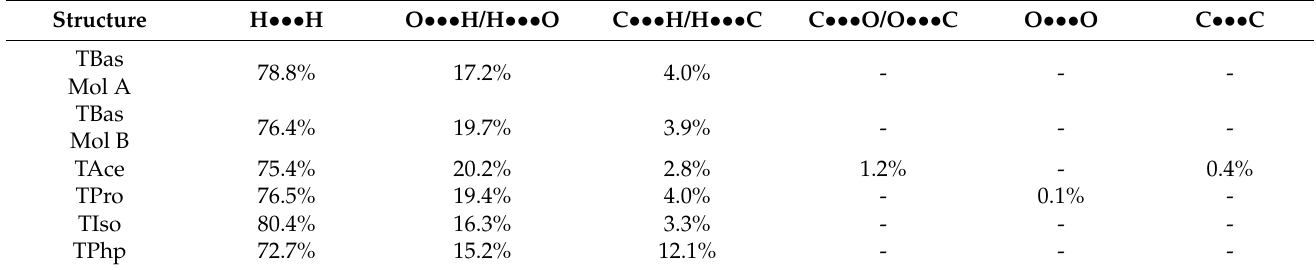
Table 3. Contributions to the Hirshfeld surfaces for various intercontacts.